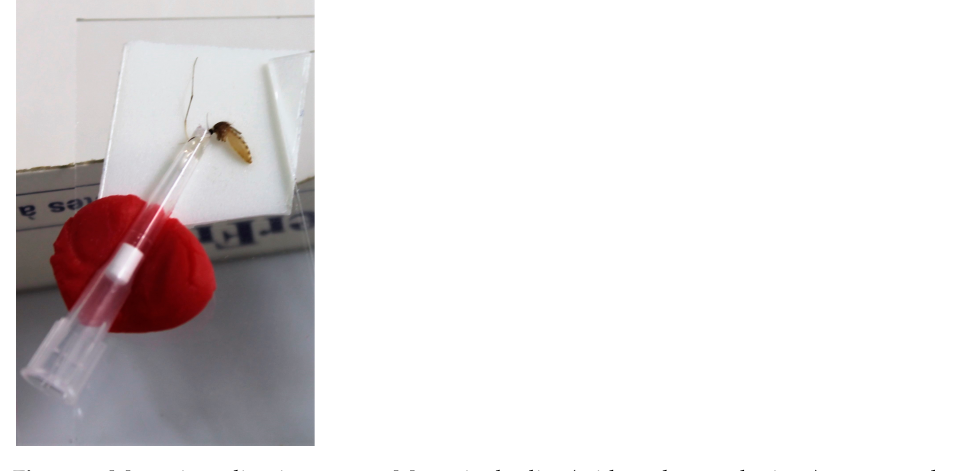
1 Figure 1. Mosquito salivation set-up. Mosquito bodies (without legs and wings) were attached to double-side tape and their proboscis was manually inserted in a pipette tip containing FBS +